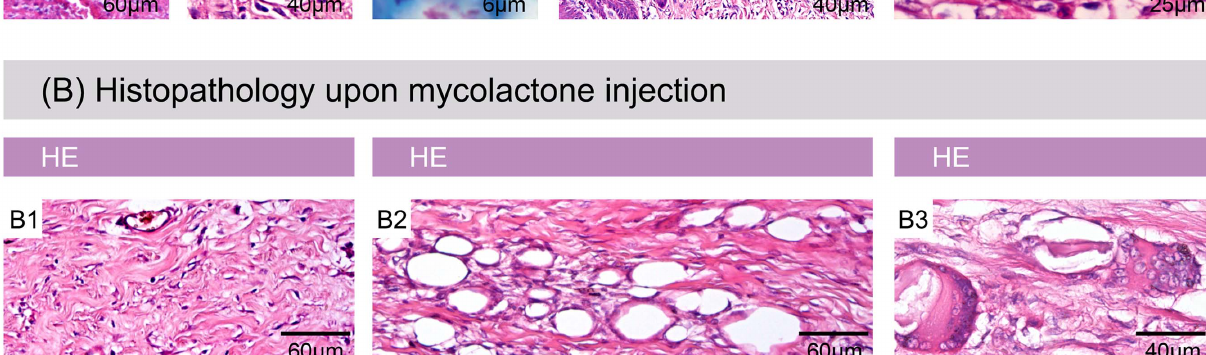
PLOS Neglected Tropical Diseases |